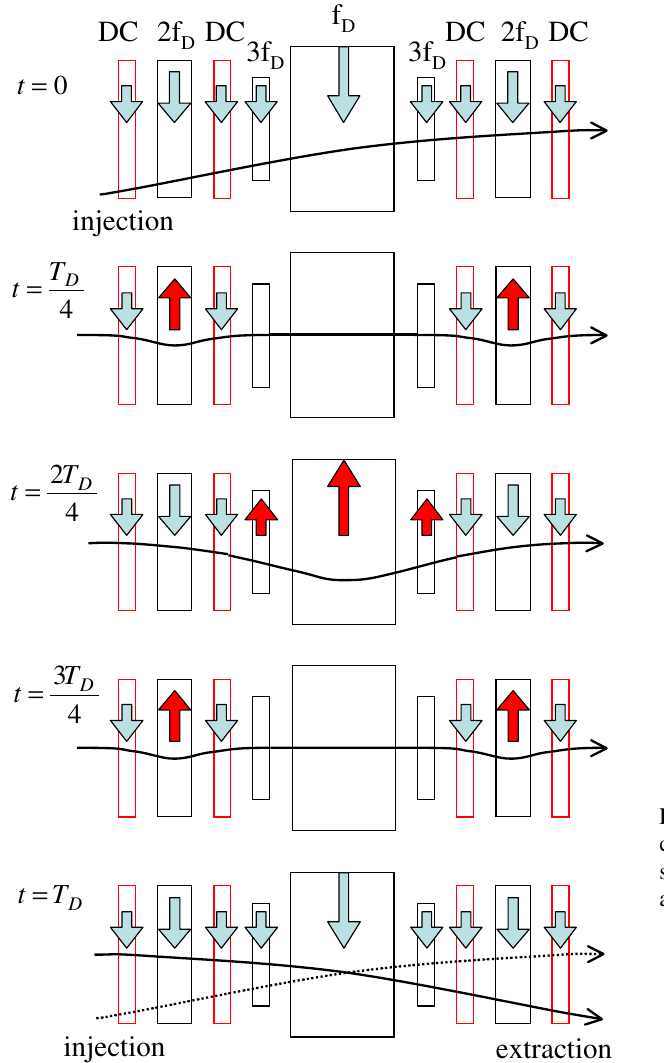
FIG. 6. (Color) Deflection of four-turn system in Fig. 5 at various timings of bunch passages. Arrows indicate direction of deflections. At t (cid:3) 0 , the deflection directions of cavities and DC magnets are the same and bunch from ERL is injected into , (cid:1) 2 = 4 (cid:2) T , and (cid:1) 3 = 4 (cid:2) T , when bunch cir- ring. At t (cid:3) (cid:1) 1 = 4 (cid:2) T D D D culates through the first, second, and third turns in ring, respec- tively, total kicks are zero and trajectories of bunch are chicanes. , when bunch circulates through the fourth turn, At t (cid:3) T D deflection is the same as t (cid:3) 0 and bunch is extracted from ring to ERL. New bunch is simultaneously injected into